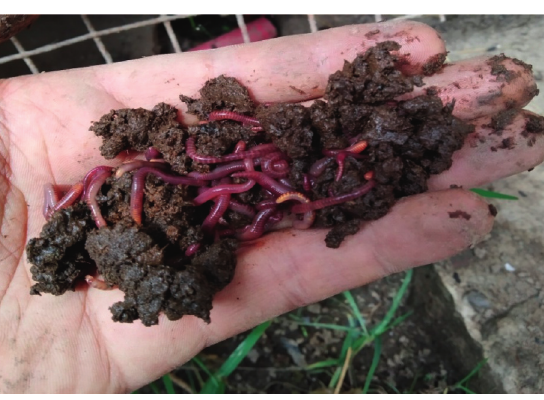
Figure 1: Number of Aporrectodea